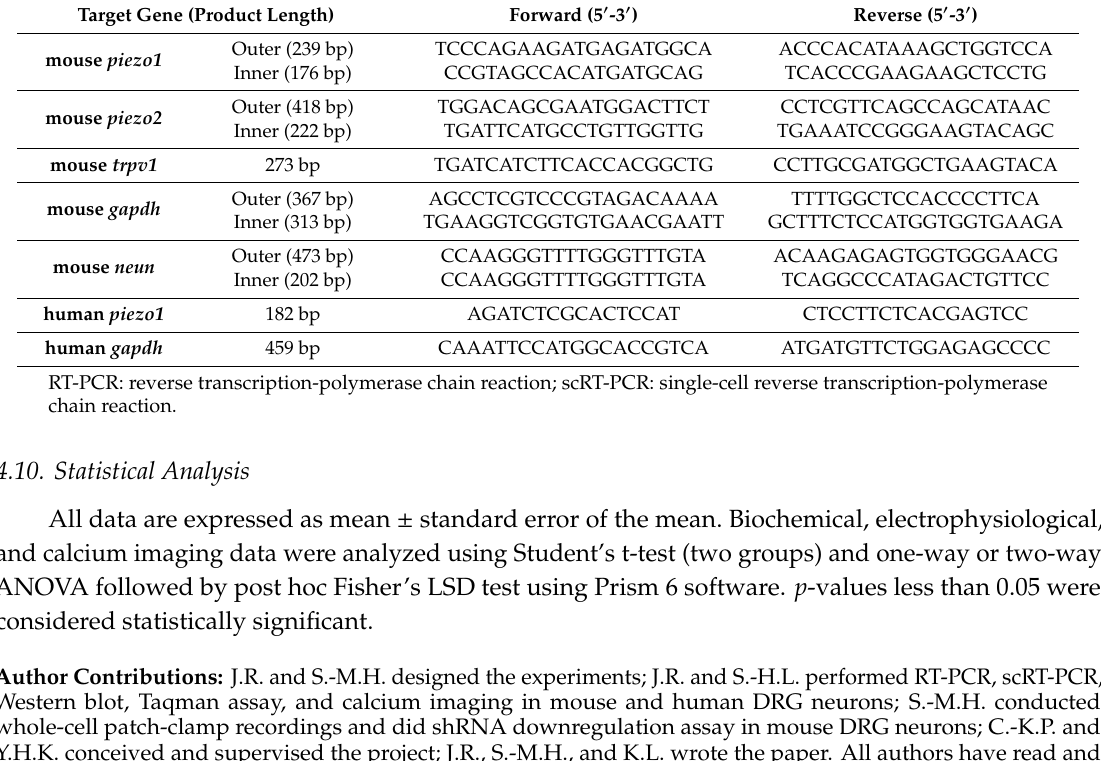
Table 2. Primer information for standard RT-PCR and scRT-PCR amplification. Target Gene (Product